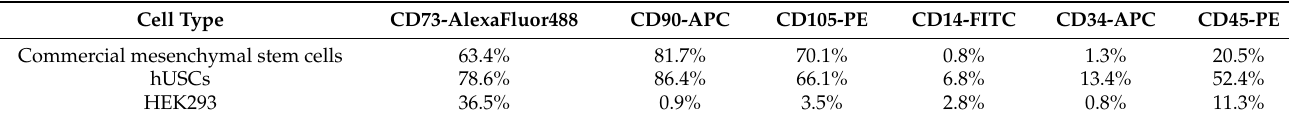
Table 1. Percentage of positive cells for each cell surface marker studied by flow cytometry. CD73, CD90, and CD105 correspond to antigens that are present specifically in mesenchymal stem cells. However, CD14, CD34, and CD45 are absent in MSCs. The different fluorophores used were FITC, APC, PE, and AlexaFluor488.